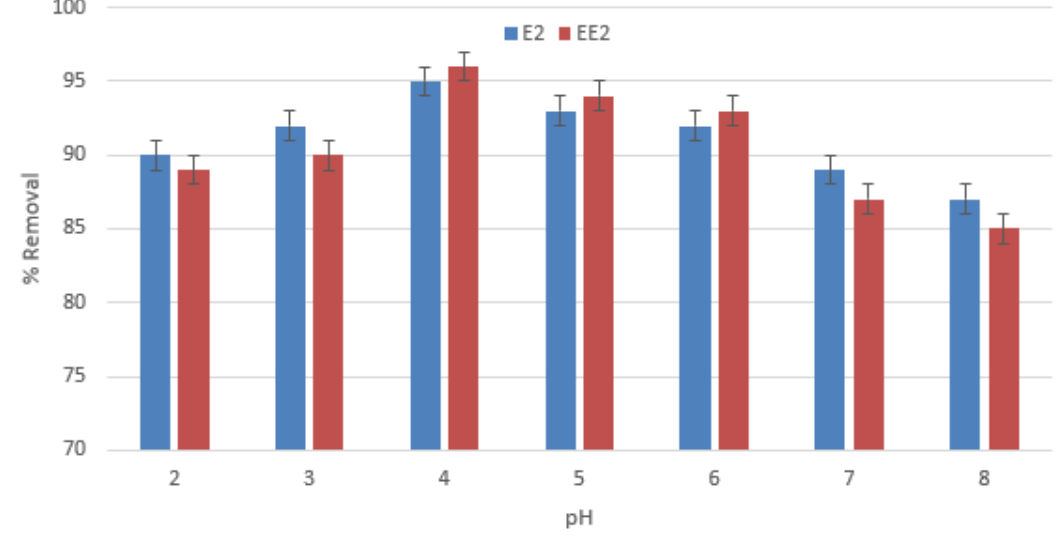
Figure 2. Effect of pH on the adsorptive removal of estradiol (E2) and 17-ethiny estradiol (EE2) by PMPS particles at a temperature of 25 °C (Error bars represent the standard deviation of the mean of the duplicates).